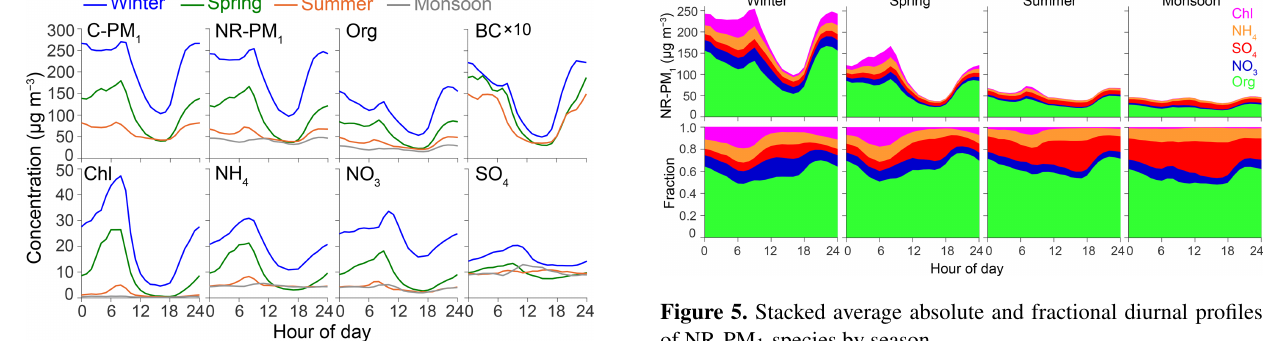
Figure 4. Average diurnal profiles of PM 1 species by season. Limited BC data for the monsoon due to instrument downtime. Composition-based estimate of PM 1 (C-PM 1 ) = BC + NR-PM 1 .